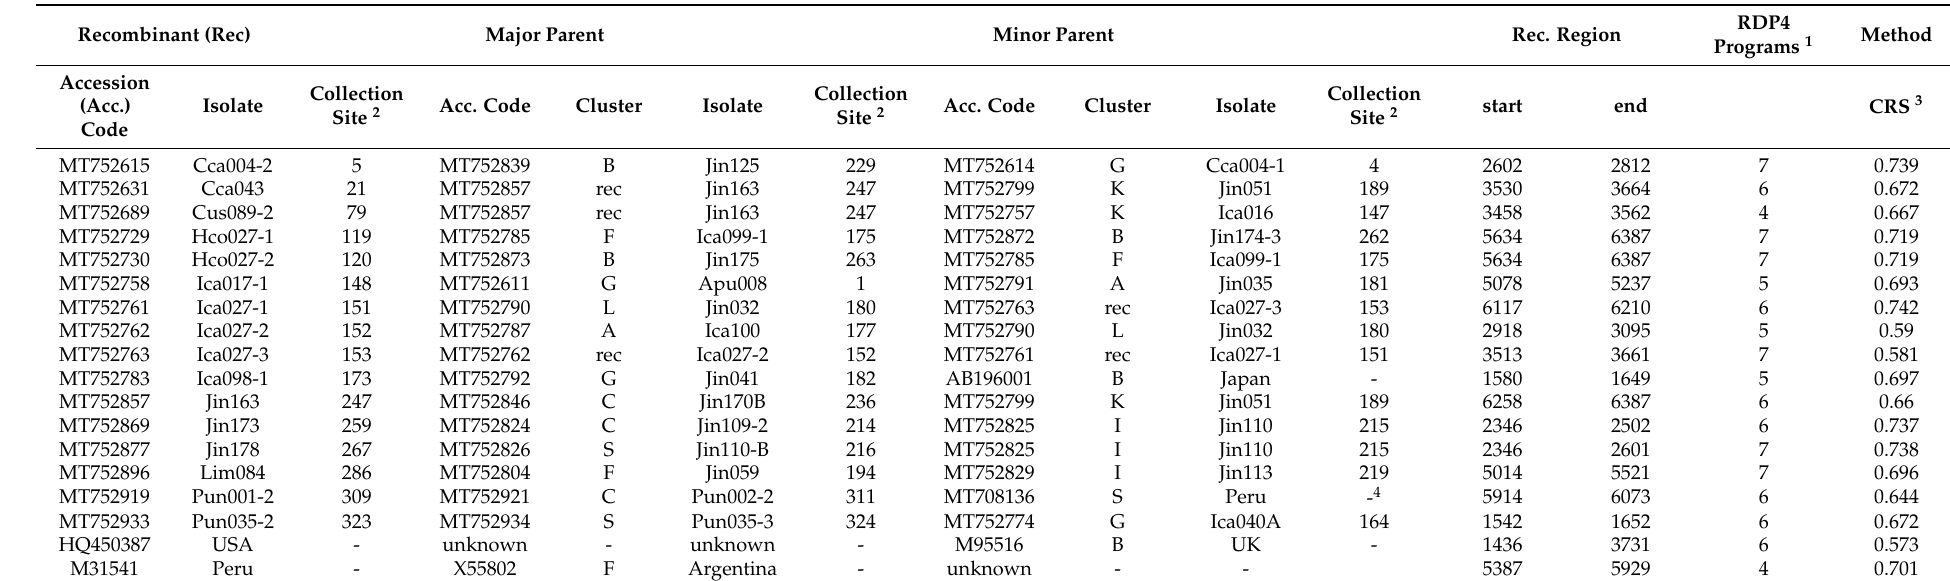
Table 2. Potato virus X recombinants and their